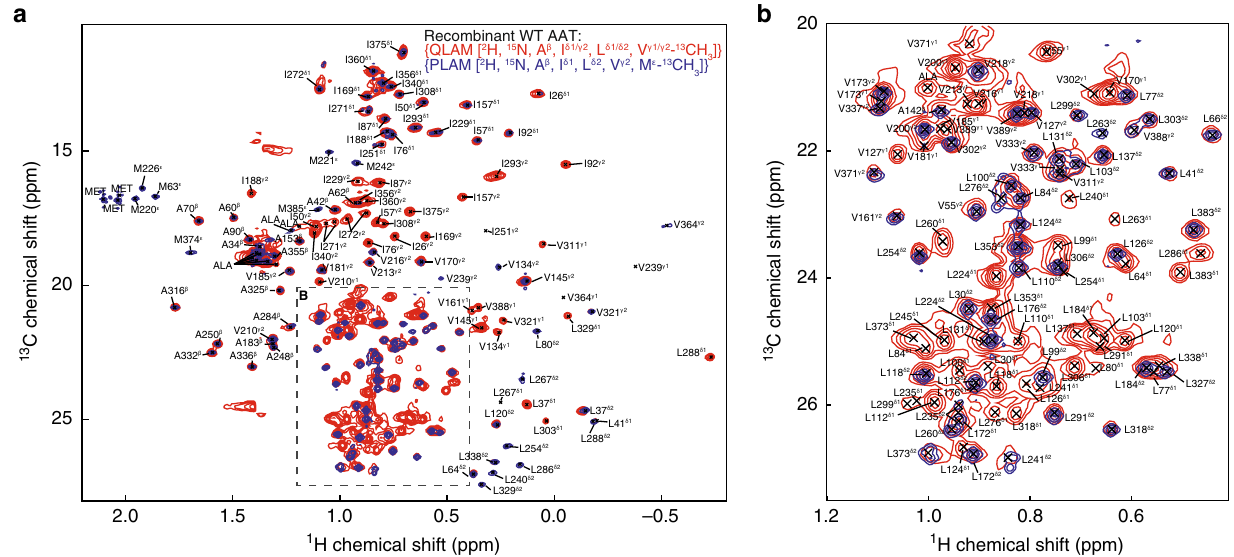
Fig. 3 Assignment of AAT methyl resonances. a Assigned 1 H, 13 C correlation spectra of recombinant wild-type AAT, prepared with two complementary methyl-labelling schemes as indicated. b Magni fi ed region of a